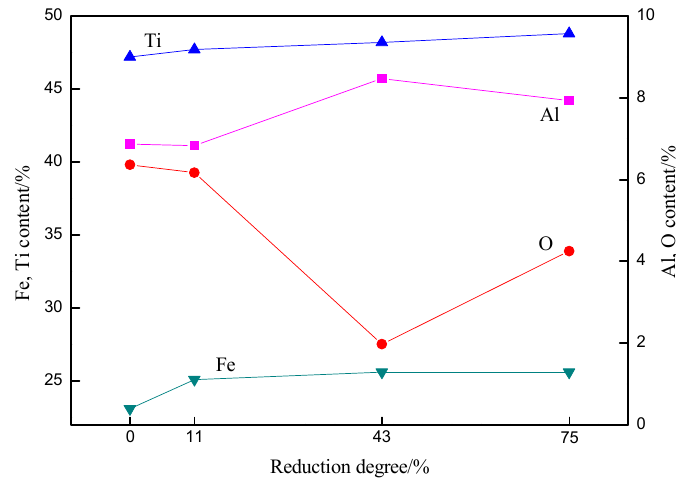
Figure 1. E ff ect of reduction degrees of ilmenite on the chemical composition of Figure 1. Effect of reduction degrees of ilmenite on the chemical composition of ferrotitanium.